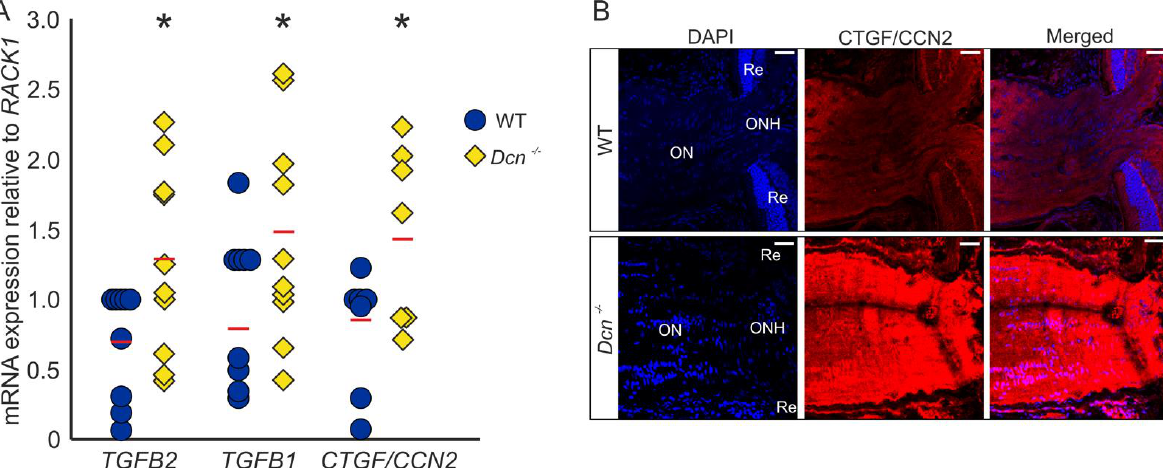
Figure 1. DCN deficiency increases the expression and synthesis of TGF-β1, -β2 and CTGF/CCN2 in the murine ON. ( A ) Expression of TGF-β2 (WT = 1 ± 0.13, n = 9, Dcn −/− = 1.85 ± 0.23, n = 10, p = 0.036), TGF-β1 (WT = 1 ± 0.15, n = 9, Dcn −/− = 1.83 ± 0.23, n = 10, p = 0.040) and CTGF/CCN2 (WT = 1 ± 0.15, n = 7, Dcn −/− = 1.84 ± 0.23, n = 7, p = 0.044) are significantly increased in the ON of DCN-deficient mice. * are significant with p ≤ 0.05. ( B ) Immunofluorescence staining against CTGF/CCN2 in the ON. Signal for CTGF/CCN2 is markedly stronger in the ON of the Dcn −/− animal compared to its WT littermate. Blue: DAPI, red: CTGF/CCN2, ON = optic nerve, ONH = optic nerve head, Re = retina. Scale bars: 20 µm.